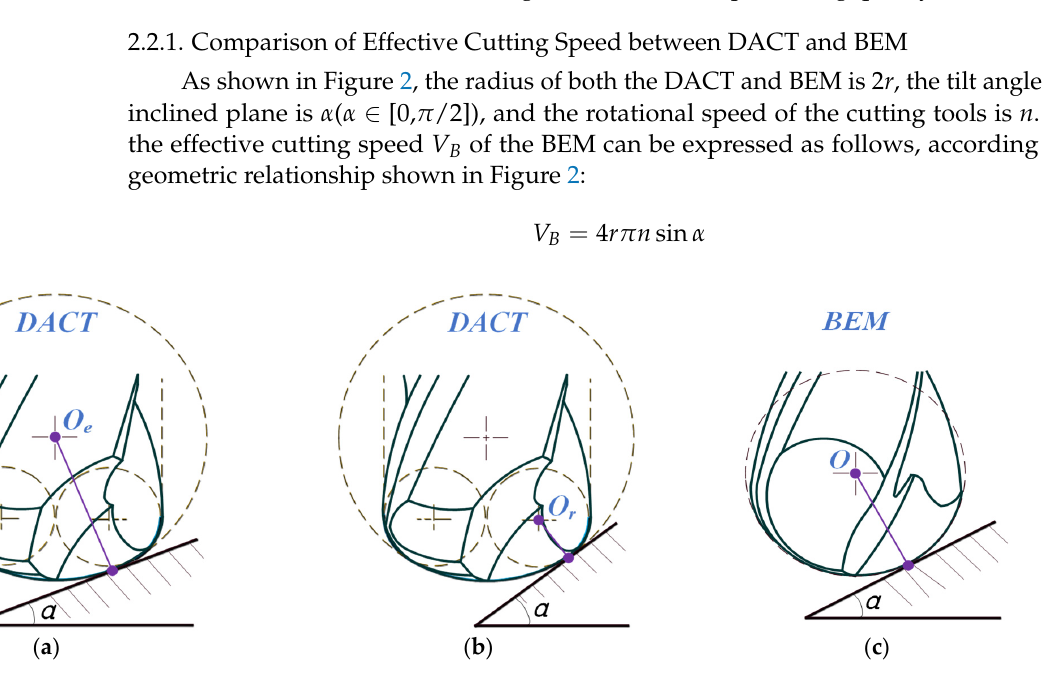
Figure 2. Schematic diagram of cutting process: ( a ) cutting contact point located on the bottom arc L e of DACT; ( b ) cutting contact point located on the ring arc L r of DACT; ( c ) cutting contact point located on circular arc of BEM.